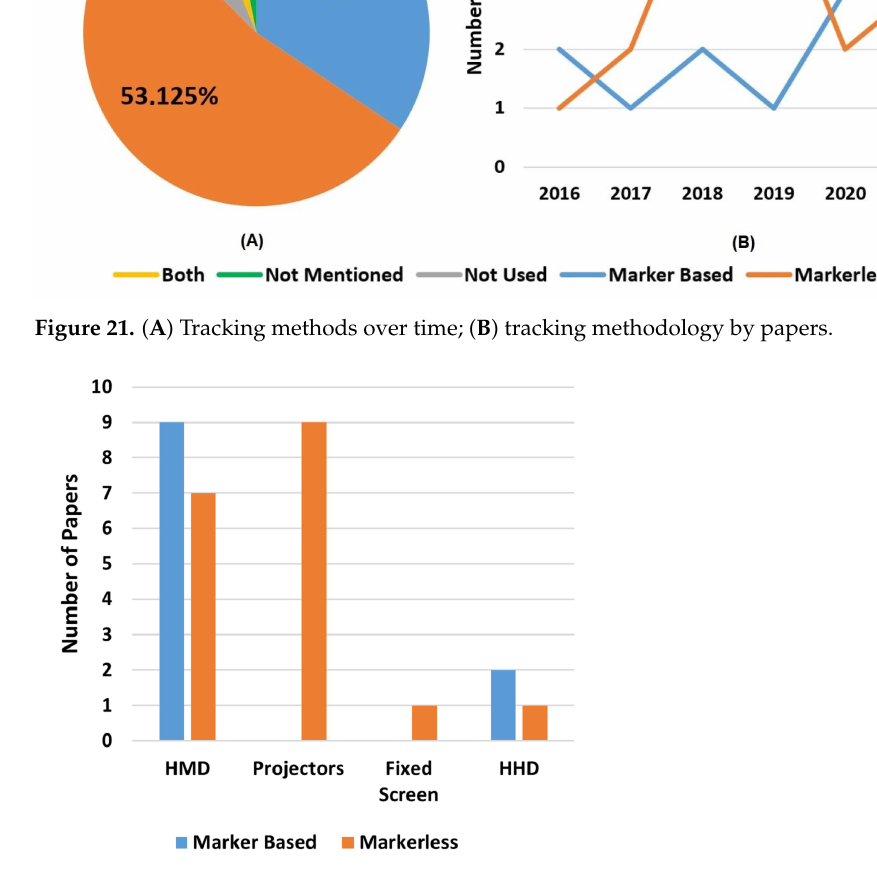
Figure 22. Tracking methodology by visualization